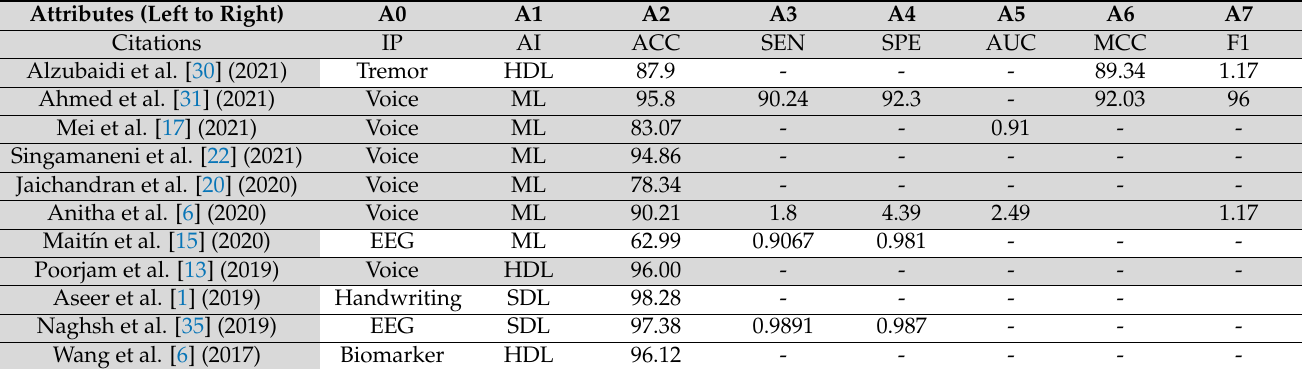
Table A3. Twelve studies showing input data type, AI architecture, and performance